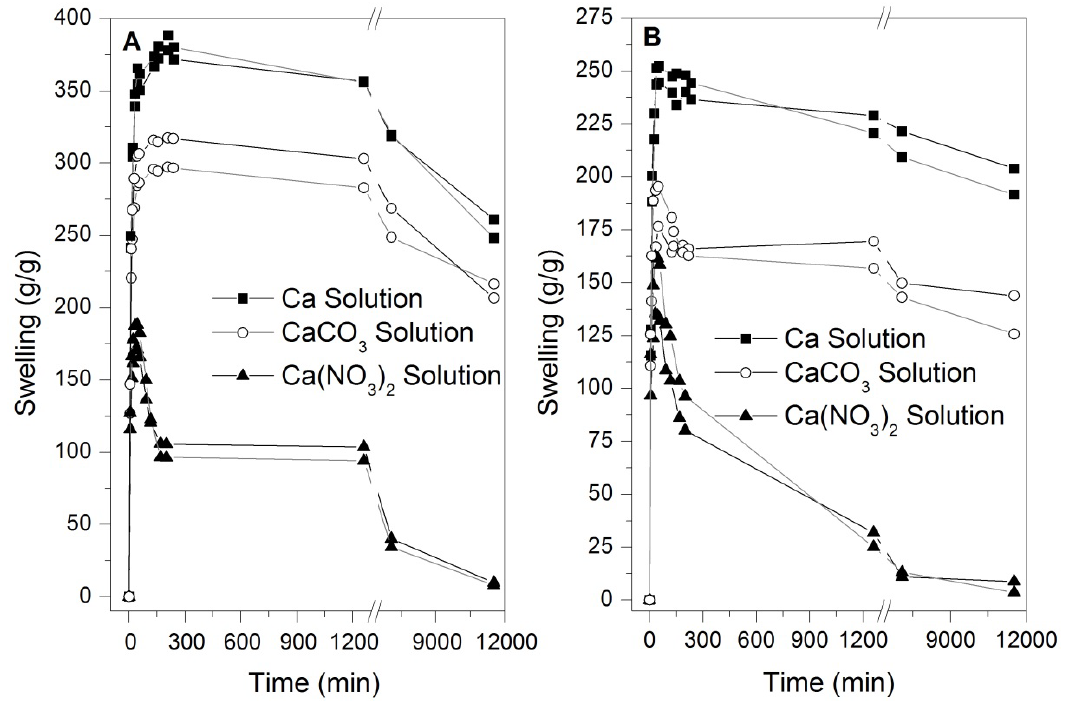
Figure 3. Swelling kinetics of hydrogels in calcium-associated solutions. ( A ) HK and ( B ) HNa.